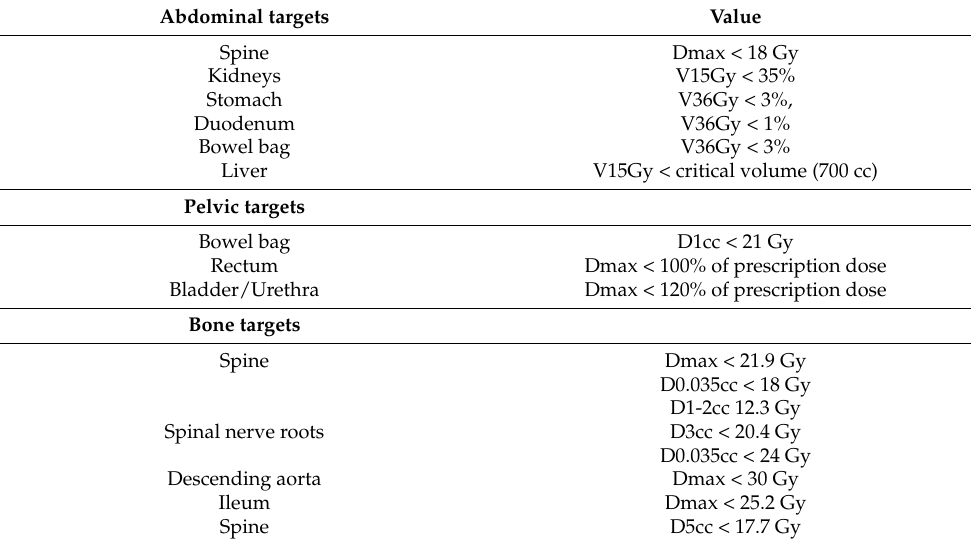
Table A1. OAR dose constraints for nodal/bone SBRT.